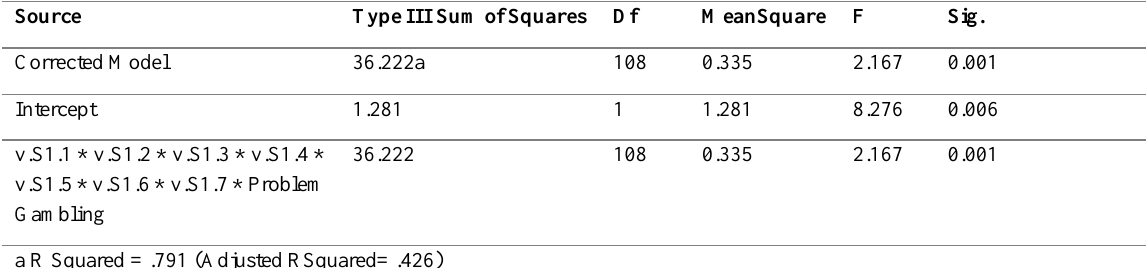
Table 9: Hypothesis Testing of Gambling Severity and Economic Wellbeing with